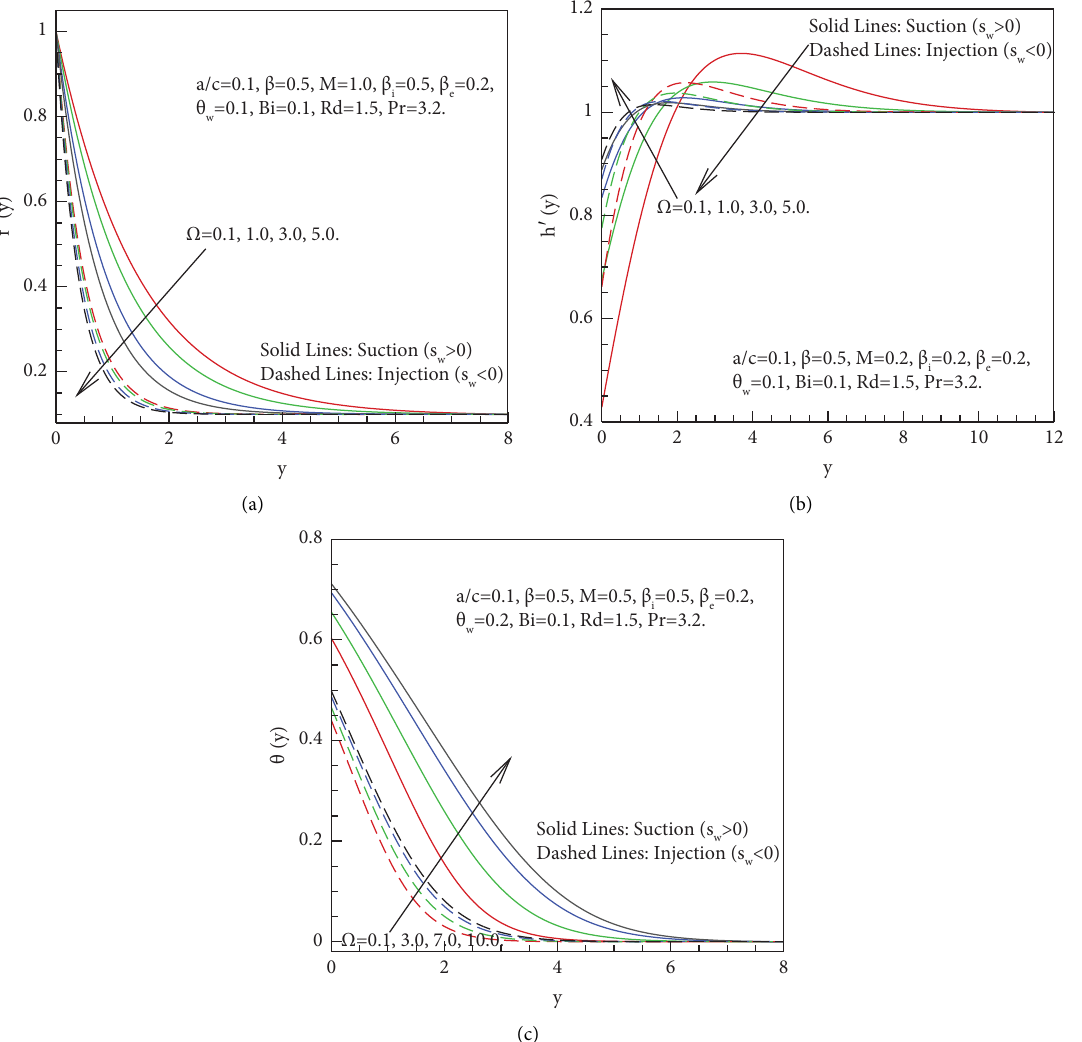
Figure 2: (a) Velocity distribution f ′ ( y ) , (b) velocity distribution h ′ ( y ) , and (c) temperature distribution θ ( y ) for permeability parameter Ω